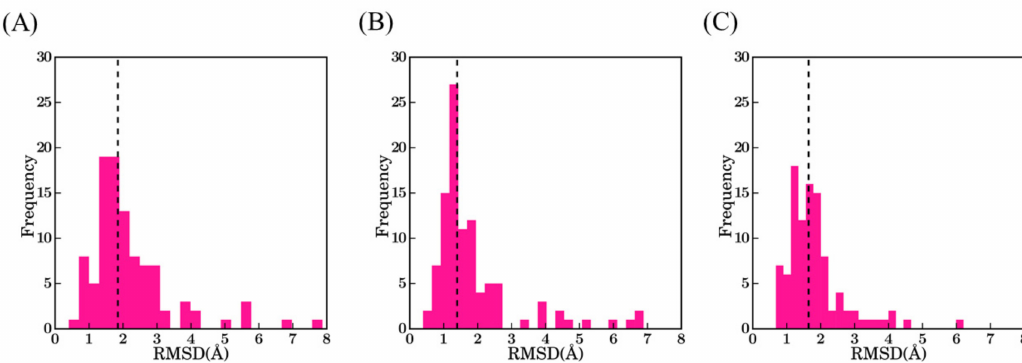
Figure 3. RMSD values between the true V H H structure and its best-selected models. ( A ) Scenario 1— bestSeqIdTemp ; ( B ) scenario 2— bestStructTemp ; and ( C ) scenario 3— 3bestSeqIdTemp . The black dotted line indicates the median value of the distributions 1.9 Å, 1.4 Å, and 1.7 Å,